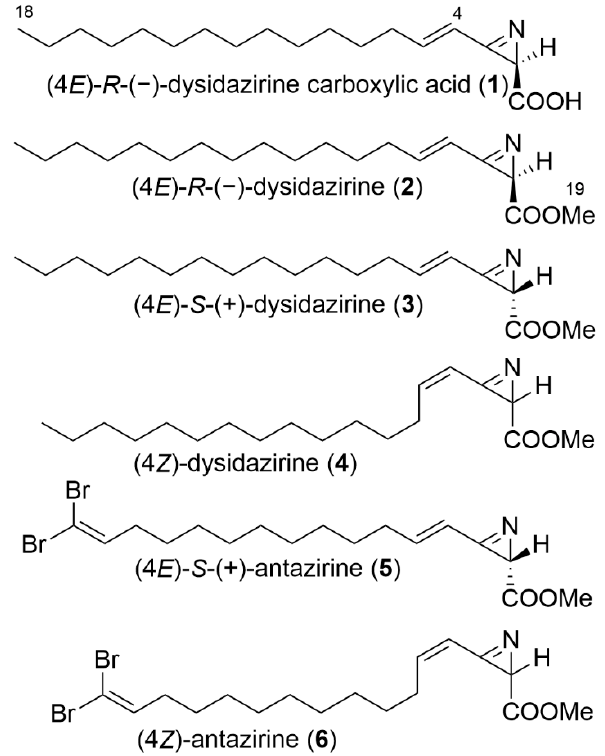
Figure 1. Chemical structures of azirine natural products.